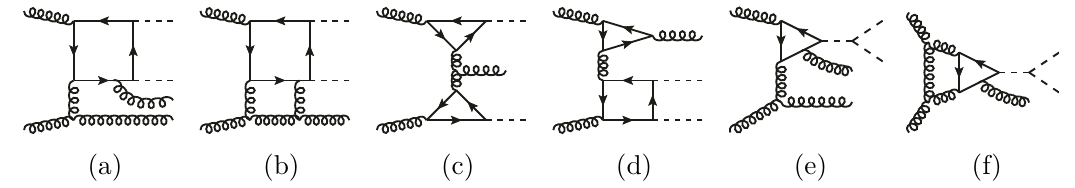
Figure 1 . Sample Feynman diagrams contributing to the real radiation. Contributions such as those shown in (c) lead to n 3 contributions which have already been computed in ref. [31]. The n 3 h contributions of (d) contain a top quark loop without a Higgs coupling and have not been computed in ref. [31]; they are considered here.